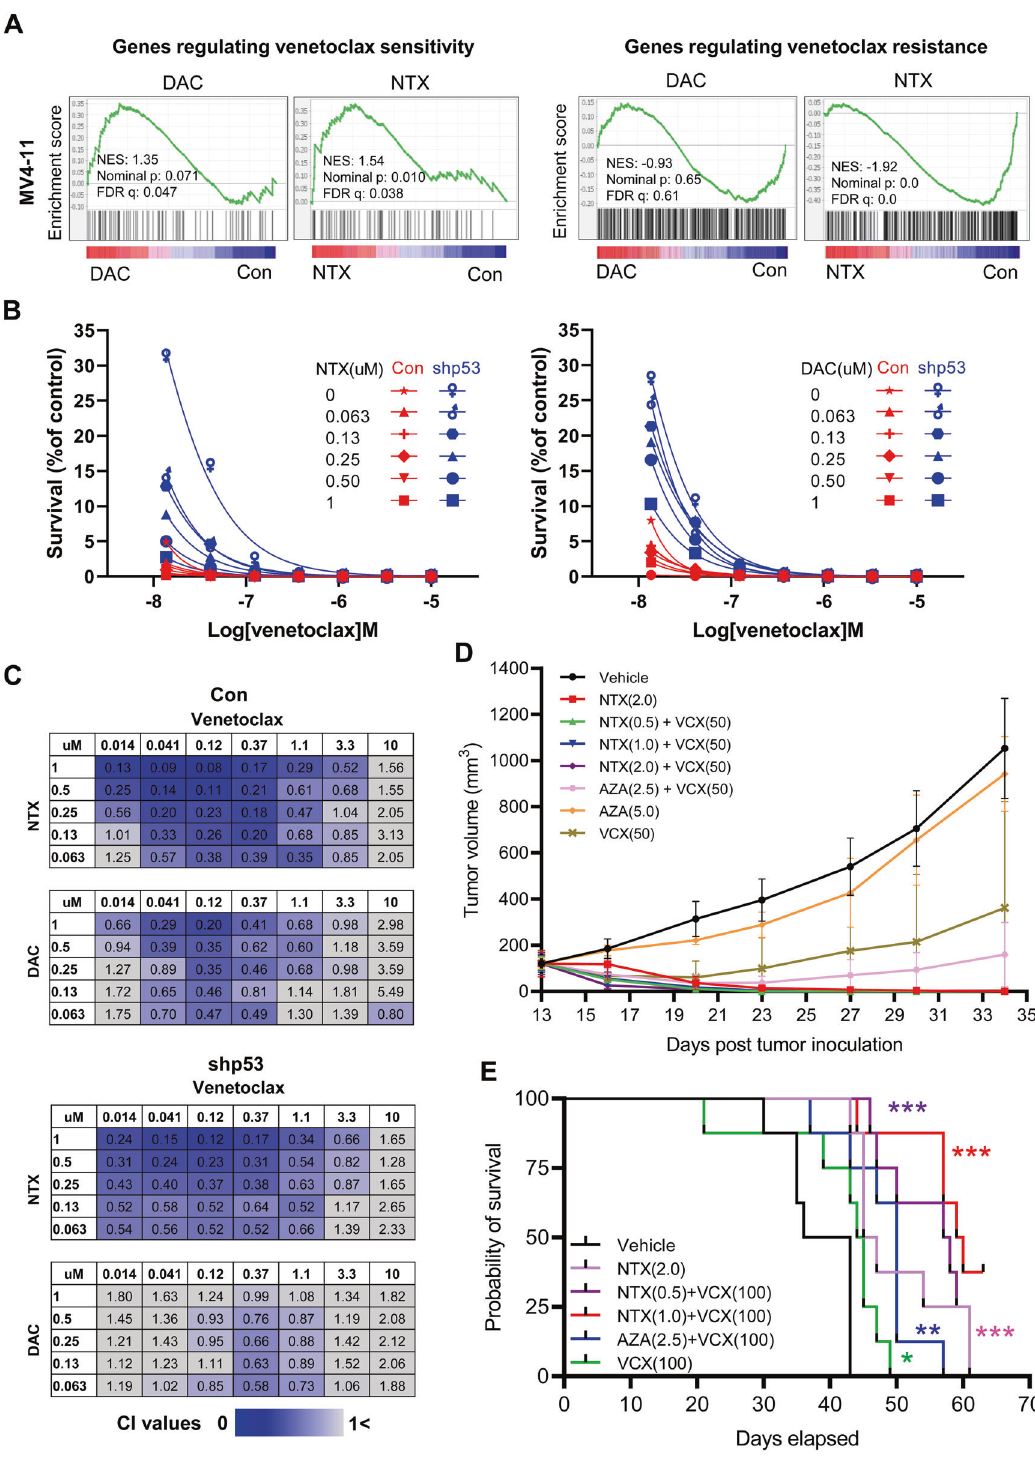
Fig. 2 NTX-301 conferred bene fi ts in combination with VCX. A GSEA plots showing signi fi cant enrichment of genes regulating sensitivity or resistance to VCX among transcriptome changes induced by 48 h of treatment with NTX-301 or DAC in MV4-11 cells. B Line plots showing the survival (%) of parental (Con) and TP53 -knockdown (shp53) MV4-11 cells upon treatment with NTX-301 + VCX (left) or DAC + VCX (right) for 72 h. C Matrices showing the combination index (CI) values upon treatment with NTX-301 + VCX or DAC + VCX for 72 h at the indicated concentrations in parental (top) and TP53 -knockdown (bottom, shp53) MV4-11 cells. CI values < 1 (blue) indicate synergistic drug combination; darker blue colors are correlated with stronger the synergism, and CI values > 1 (gray) indicate no synergism. D Growth of MV4-11 tumors subcutaneously implanted into female BALB/c nude mice ( n = 5 per group, eight groups) upon treatment with NTX-301 or AZA as a monotherapy or in combination with VCX. E Kaplan – Meier curves showing the survival probabilities of female NCG mice ( n = 8 per group, six groups) intravenously injected with MV4-11 cells upon treatment with NTX-301 or AZA as a monotherapy or in combination with VCX. AZA azacitidine, DAC decitabine, NTX NTX-301, VCX venetoclax. * p < 0.05; ** p < 0.01; *** p < 0.001.